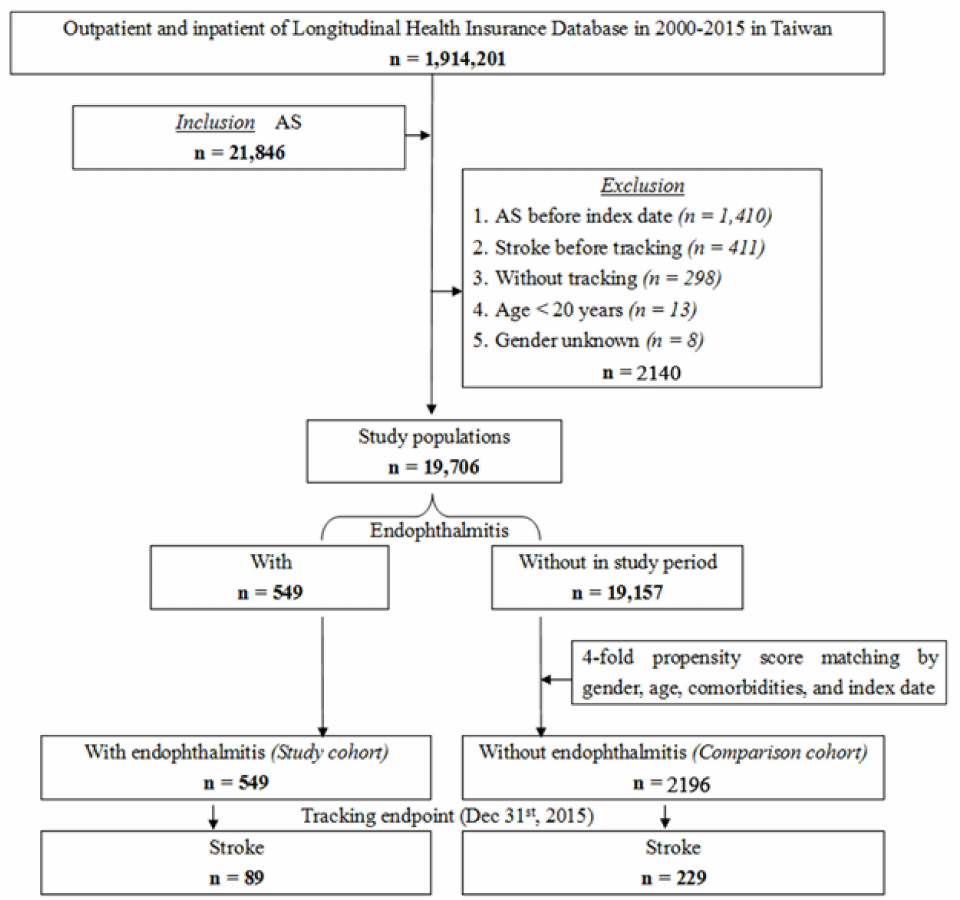
Figure 1. Algorithm of patient selection process. The inclusion criterion was ankylosing spondylitis. The exclusion criteria were diagnosis with ankylosing spondylitis before the inclusion date, stroke before tracking, lack of tracking, age < 20 years, and unknown